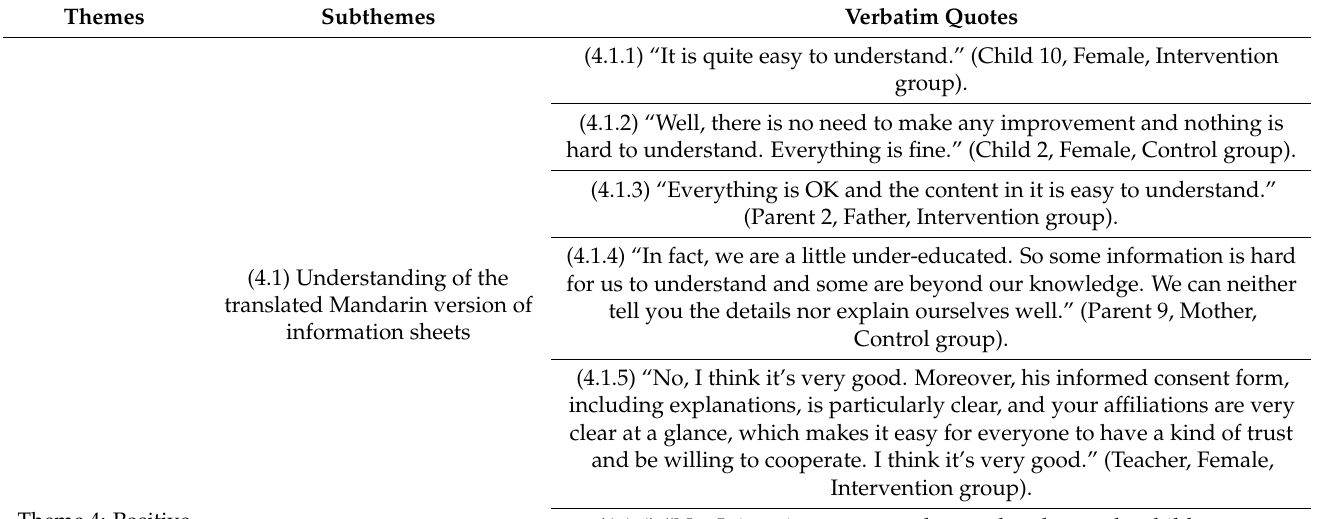
Table 4. Experiences and perceptions of participating in the